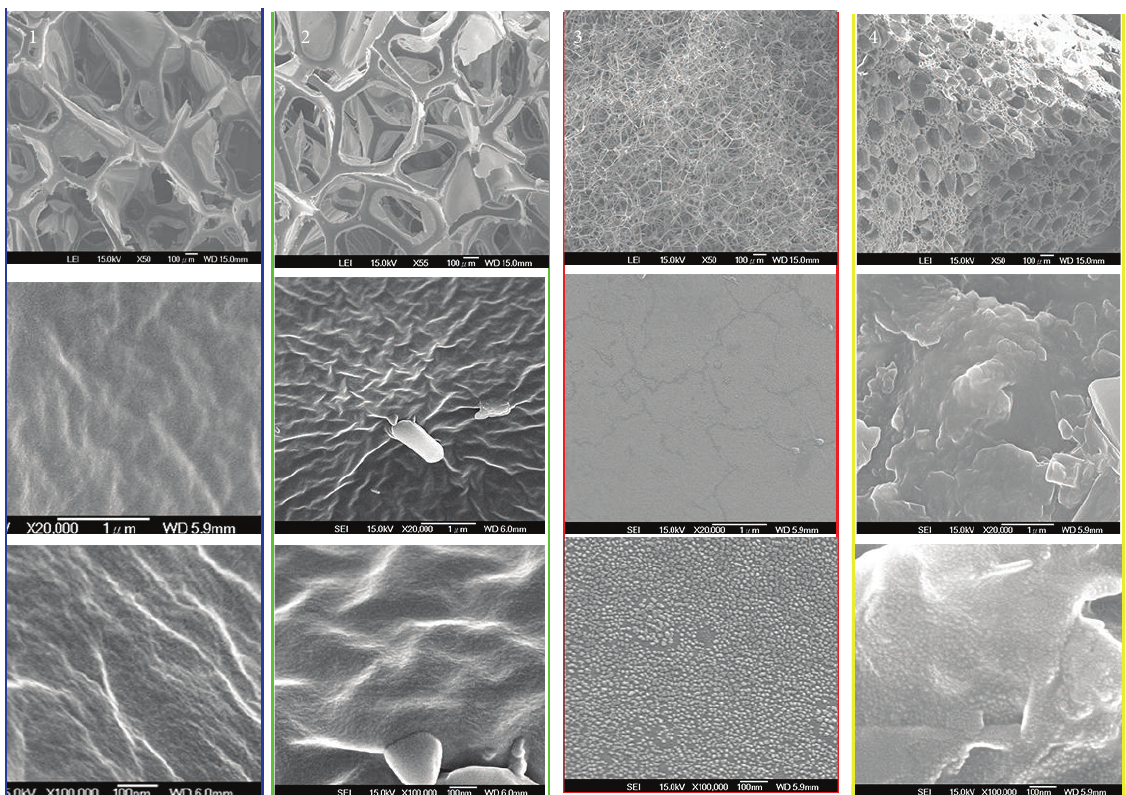
Figure 2: Surface configuration of different fireproof foams in magnifications of 50, 20000, and 100000.